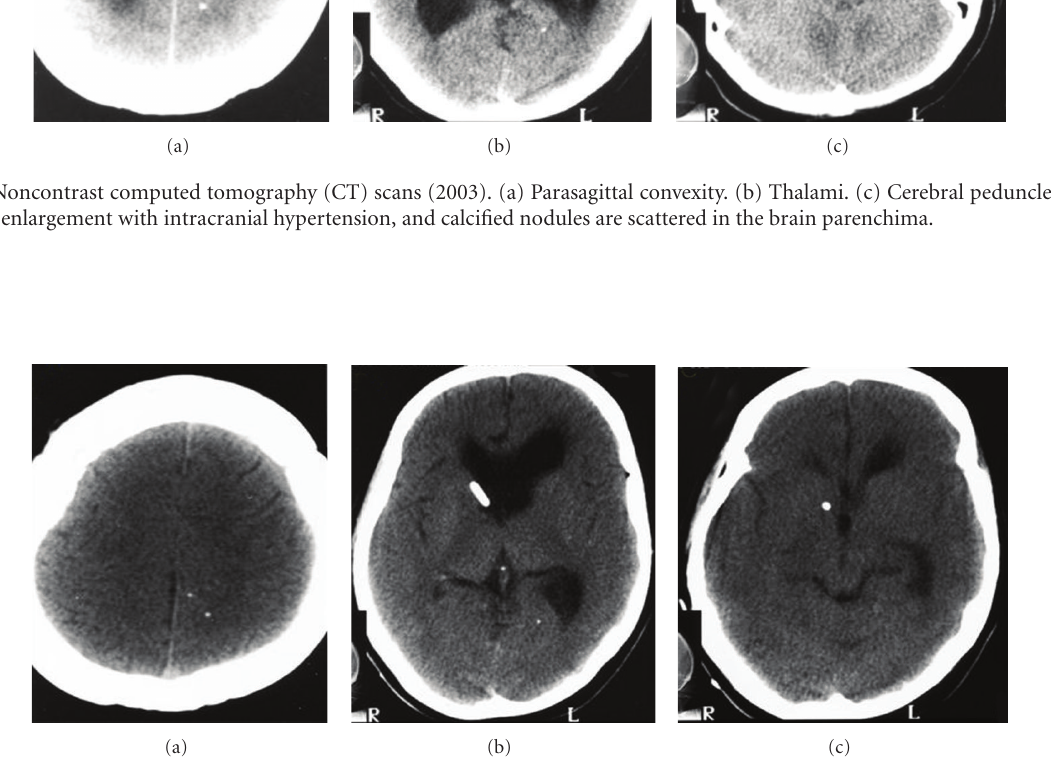
Figure 2: Noncontrast CT scans (2003). Ventriculo-peritoneal shunt. Calcified nodules are scattered in the parenchyma. There is improvement of intracranial hypertension, as compared to Figure 1.